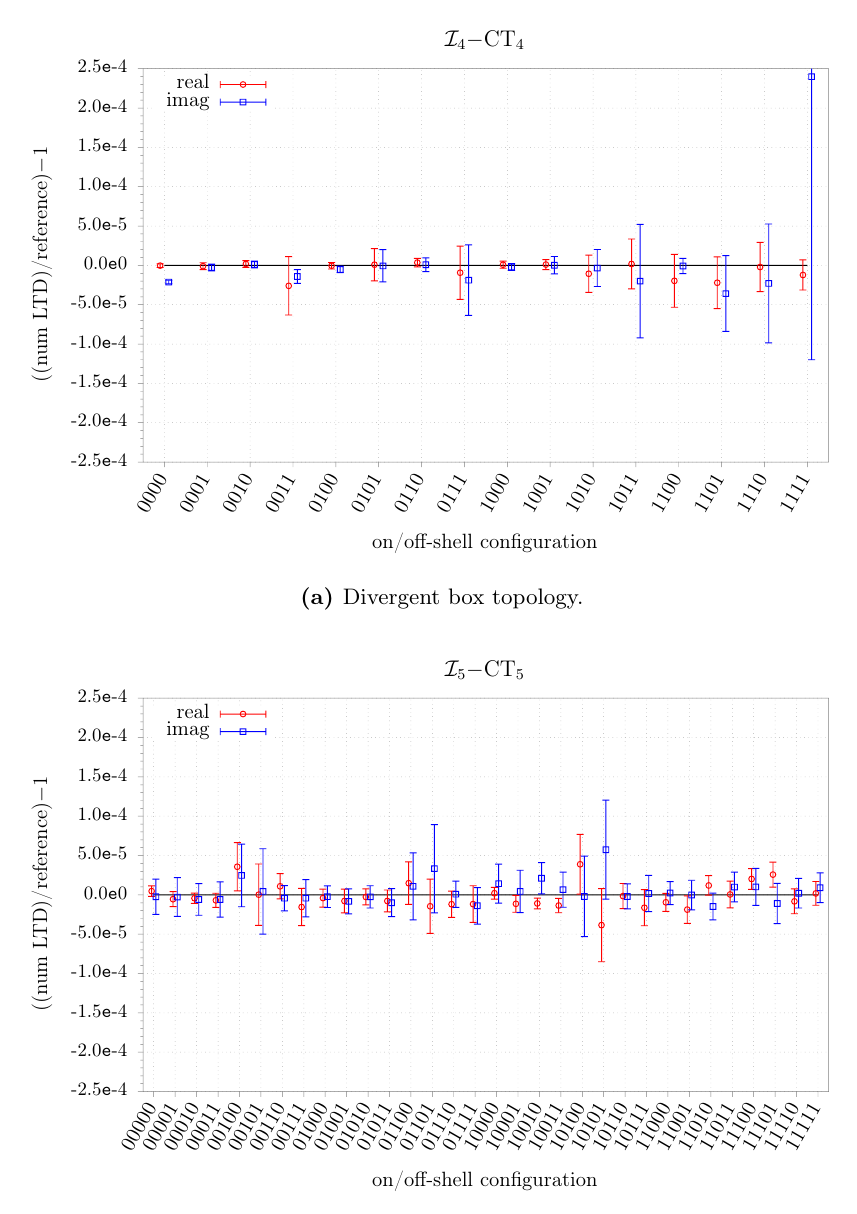
Figure 21. Results for the computation of divergent four- and (cid:12)ve-point scalar one-loop integrals. We show the real and imaginary part of the expression integrated with LTD, compared with the analytic expression computed with MadLoop5 [105, 106]( ML5 ) and qcdloop [115]. The (nomi- nal) horizontal axis shows di(cid:11)erent phase-space con(cid:12)gurations using a binary notation, where a 1 (resp. 0) in the i th position signi(cid:12)es that the i th external momentum is on-shell with p 2 o(cid:11)-shell, that is with p 2 = 0). All but one of the central values are within 0.005% of the analytical i 6 result. The outlier with con(cid:12)guration 1111 lies within 0.024% of the analytical result and has a relative standard error of